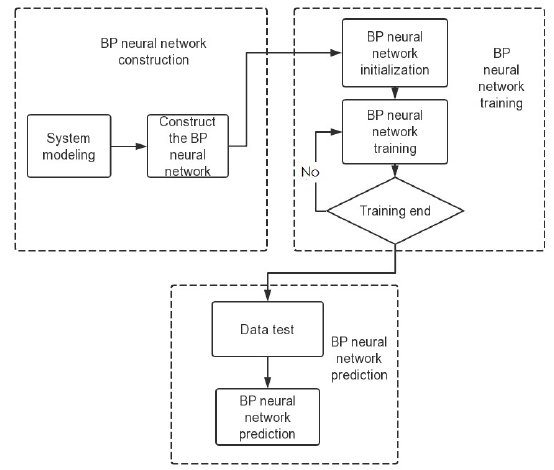
Figure 6. Backpropagation (BP) neural network algorithm process.